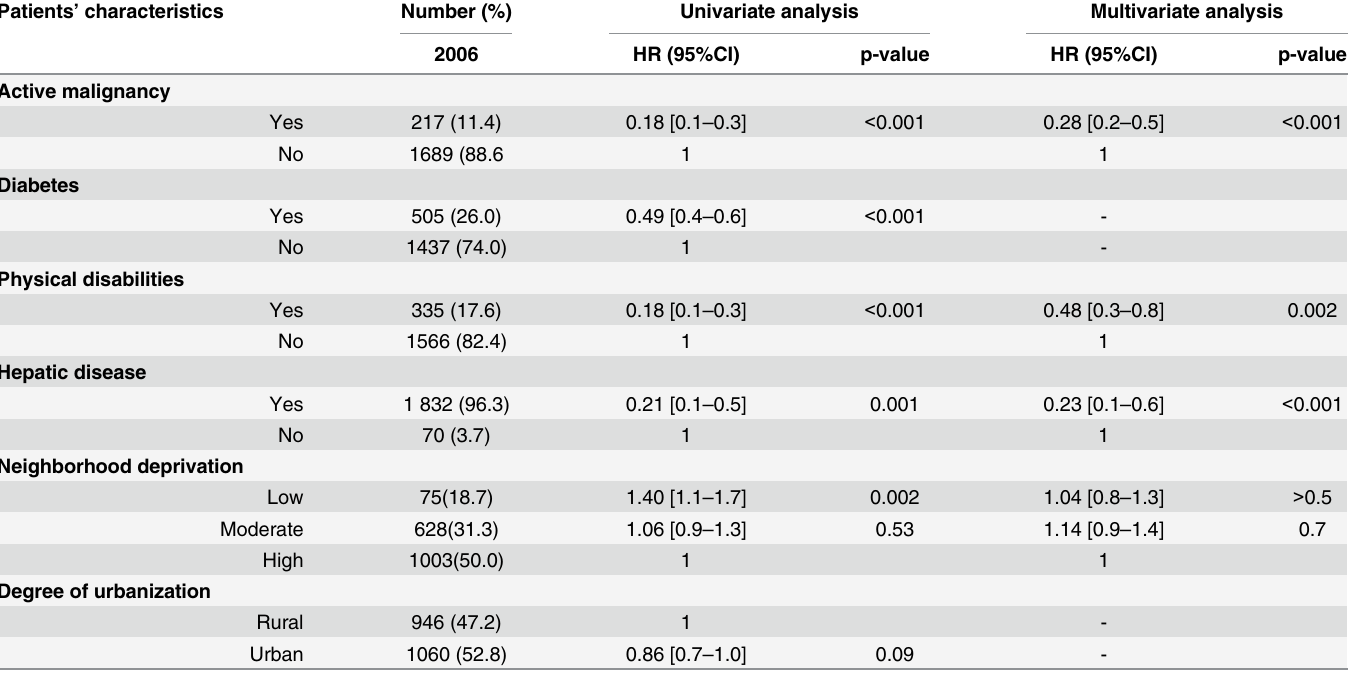
transplant waiting list. The presence of co-morbidities, physical disabilities, low serum albumin level ( < 30 g/dl), high BMI value ( (cid:1) 35kg/m²), emergency first dialysis ( vs planned one) and all pri- mary renal diseases (compared with polycystic kidney disease) were significantly associated with a lower probability of being wait-listed. Patients living in less disadvantaged census-blocks had higher access to the waiting list than those living in highly disadvantaged areas. Similarly, access to the waiting list was higher for patients living in urban areas than for those living in rural census-blocks. (b) Multivariate analysis. Young patients (18 – 39 years) were more likely to be placed on the waiting list (aHR = 29.81 95%CI: [18.1 – 49.1]). Patients with a cardiovascular disease, hepatic dis- ease, active malignancy or physical disability were less likely to be placed on the list than patients without comorbidity (adjusted HR, aHR = 0.52 95%CI: [0.4 – 0.7]; aHR = 0.23 95%CI: [0.1 – 0.6]; aHR = 0.28 95%CI: [0.2 – 0.5]; aHR = 0.48 95%CI: [0.3 – 0.8], respectively). Similarly, emergency first dialysis session was still associated with a lower probability of being wait-listed (aHR = 0.59 95%CI: [0.5 – 0.8]). Patients followed in private facilities were 41% more likely to be registered on the waiting list than patients followed in public non university centers. Conversely, neighborhood deprivation was not significantly associated with access to the waiting list in multivariate analysis.